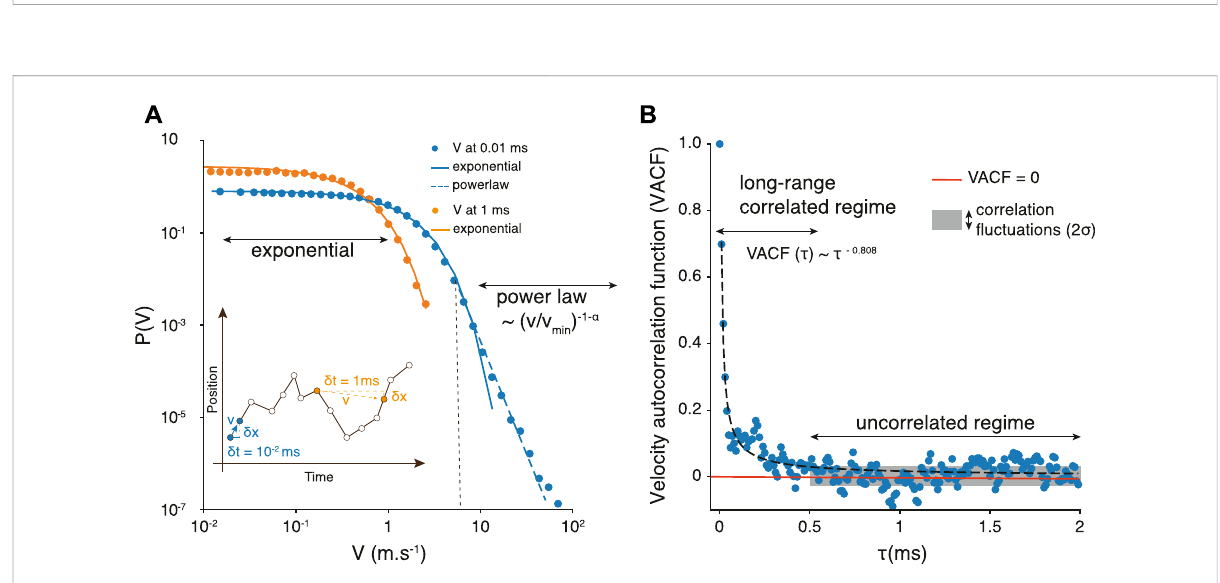
FIGURE 3 (A) Velocity probability distribution P ( v ) obtained from sampling the platelets trajectories at a time resolution δ t = 10 – 5 s (blue), and δ t = 10 – 3 s (orange). The straight lines represent an exponential decrease and the dashed one a powerlaw behavior, hence suggesting a velocity distribution described by Eq. 5. The distributions were computed with logarithmically spaced bins. The inset indicates how velocities are measured from trajectories samples at different values of δ t . (B) Platelet velocity auto-correlation function VACF ( τ ) (cid:1) 〈 v i ( t + τ ) v i ( t ) 〉 i as a function of the time delay τ . The fi t of the data points gives a power law relation, VACF( τ ) ~ τ − b , with b =